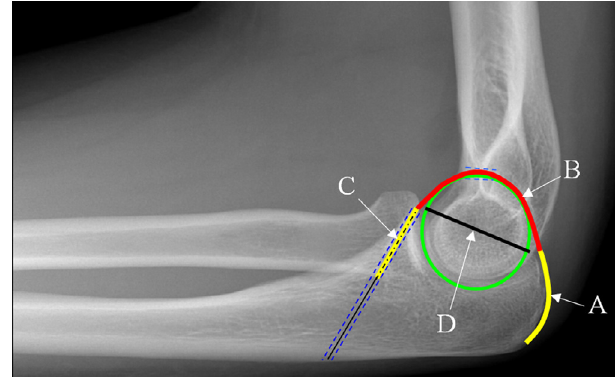
Figure 7. Lateral radiograph of an elbow with superimposed schematic of the reconstruction. The length of tendon required = A + B (1/2 p D) +